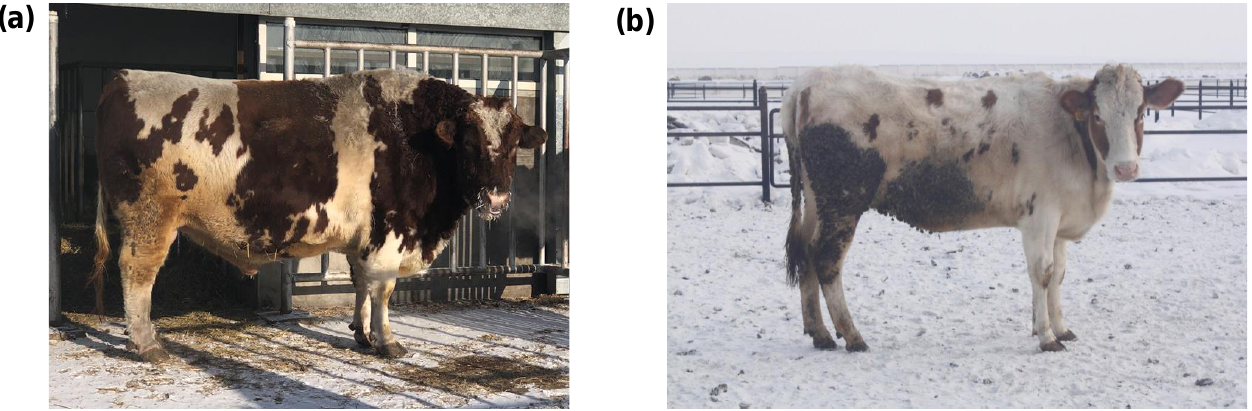
Figure 2. Sanhe cattle during severe cold stress exposure. ( a ) Young bull, and ( b )